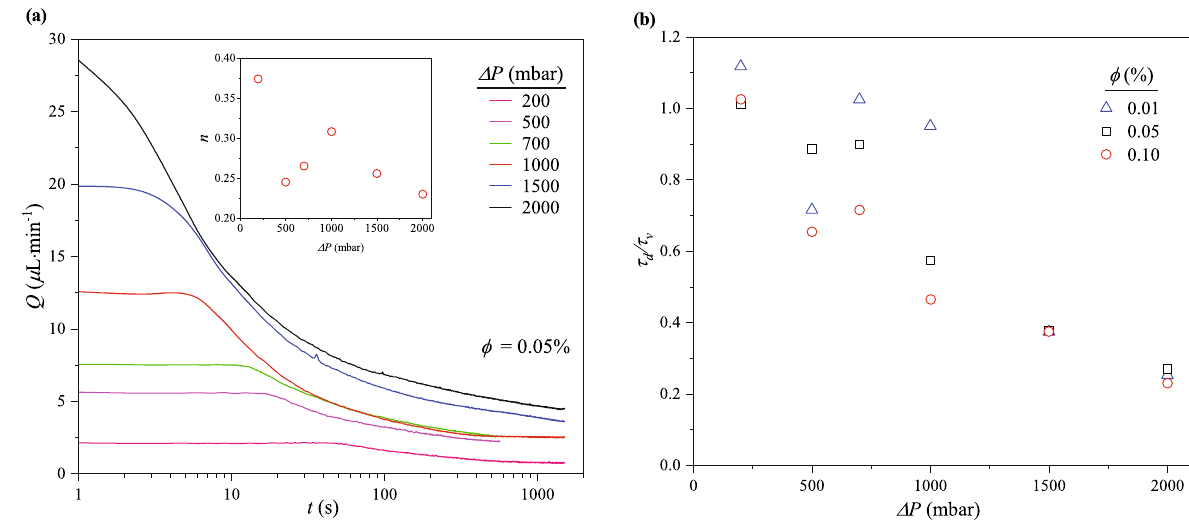
Figure 4. ( a ) Suspension flowrate decays over time at different (cid:31) P for φ = 0.05% . Three processes including clogging by sieving, clog growth, and cake filtration are identified. Inset: Exponent, n , of the power-law decay associated with the clog growth subprocess as a function of (cid:31) P . ( b ) Ratio of decay start time ( τ d ) to time required to fill the microfluidic device with pure water ( τ v ) as a function of (cid:31) P . For each φ , τ d /τ v ≈ 1 at relatively low (cid:31) P , but decreases as (cid:31) P